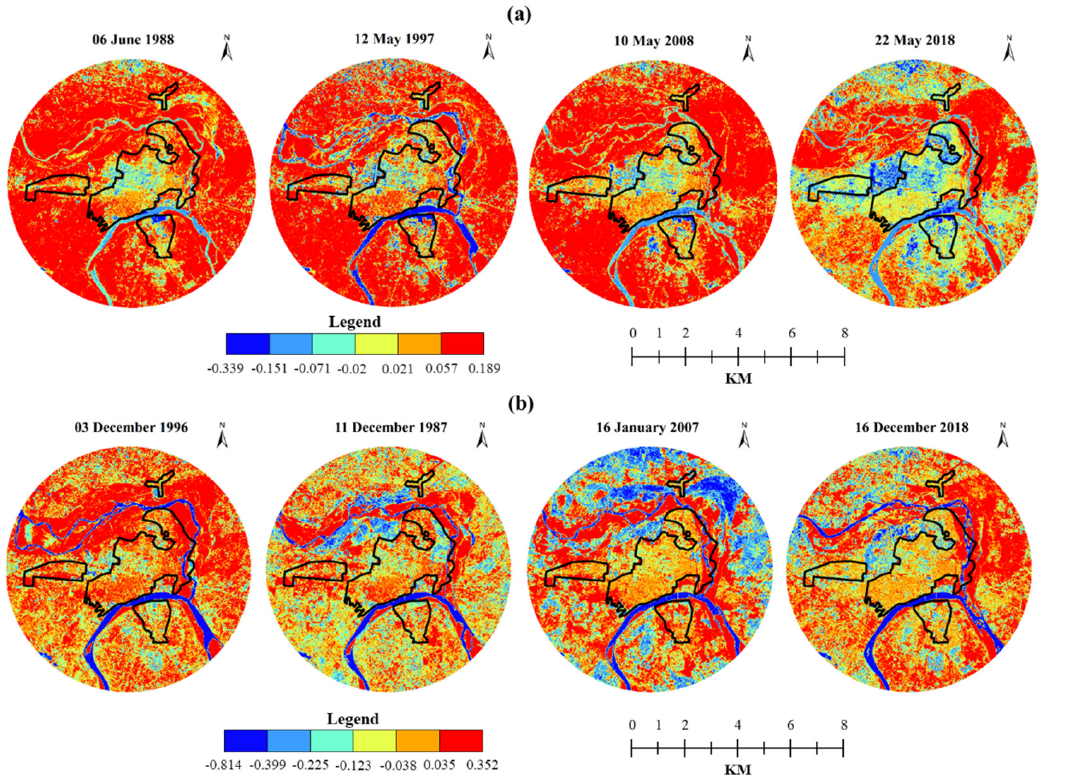
Figure 7. Seasonal NDBI dynamics in Prayagraj city (1987–2018): ( a ) summer and ( b ) winter. Most of the highly dense impervious/built-up area was intensely concentrated in the city center to the south in S1 and W1, which further expanded in the south in S2, W2, S3, and W3. In S4 and W4, the highly dense built-up area spread in the southwest and northeast in S4 and W4, respectively. Therefore, it is apparent that the built-up area is mostly concentrated in the southwest and northeast up to 8